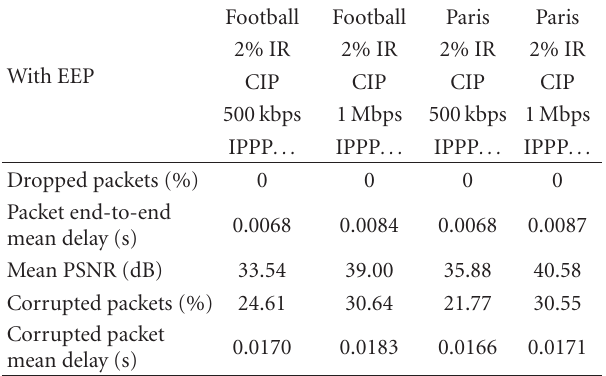
Table 4: Mean per frame overhead in bytes from rateless coding for the Football sequence.